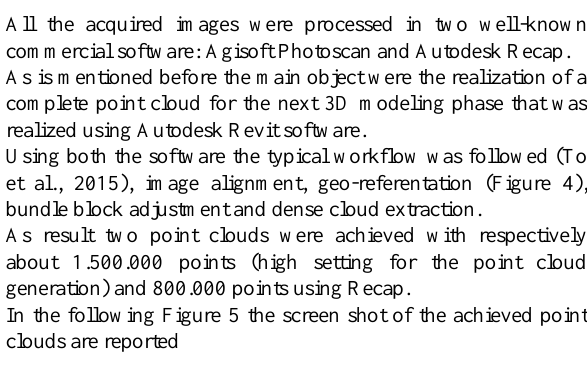
Figure 3. Part of a dataset acquired by a Canon 600D with a 18 mm (shooting distance= 3 m; GSD= 0.7 cm